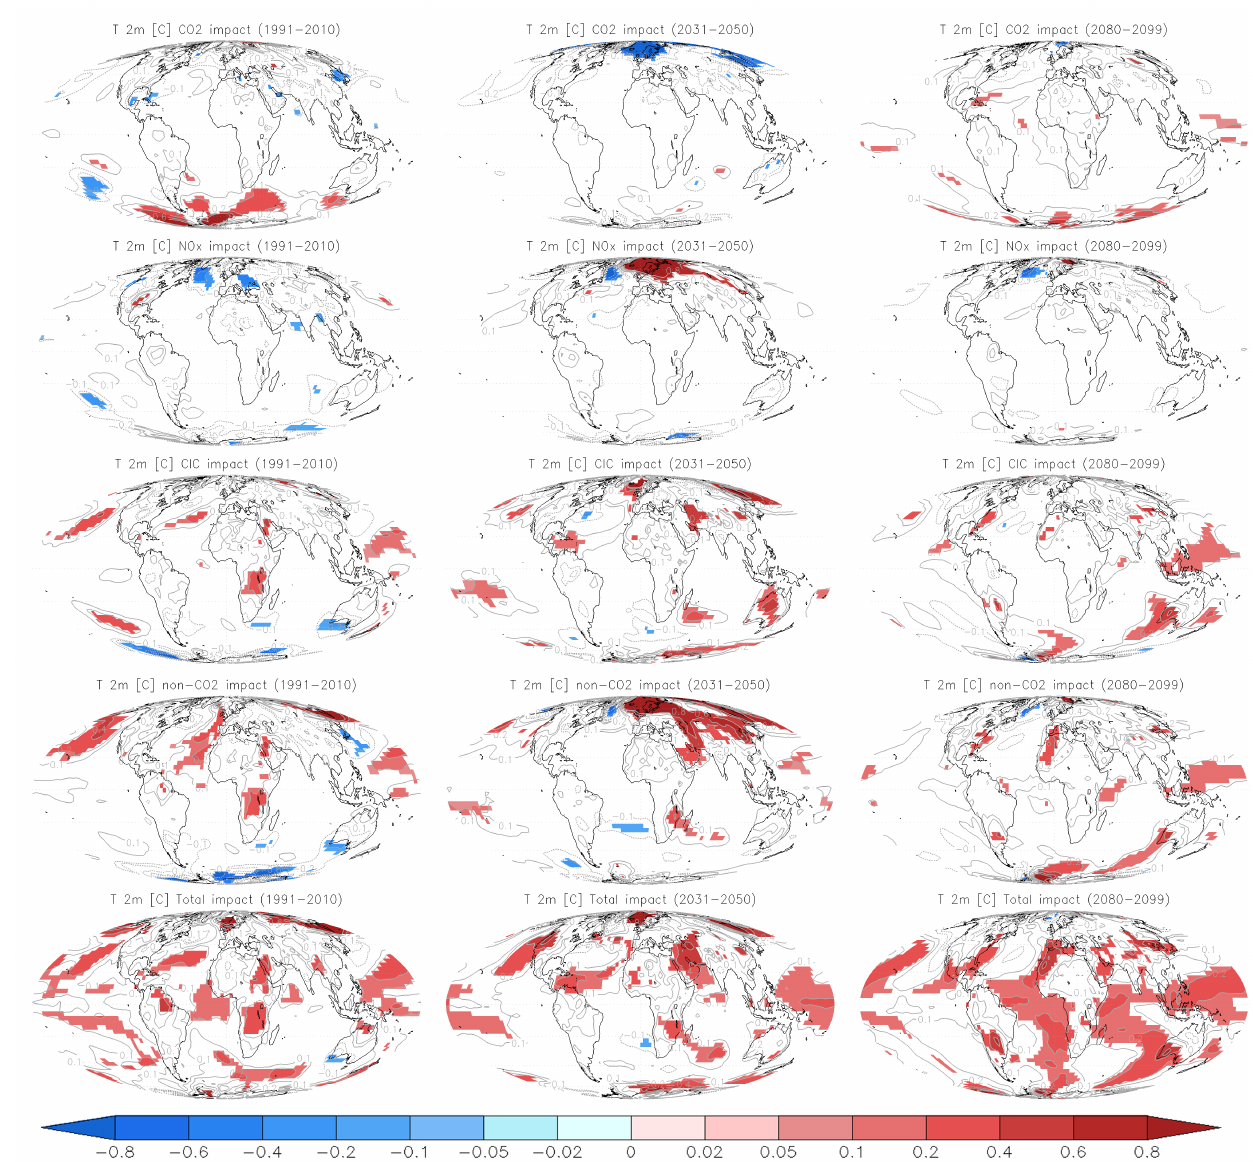
Fig. 10. Impact of aviation on near-surface temperature averaged over 1991–2010 (left column), 2031–2050 (middle column) and 2088–2099 (right column). Rows represent the CO 2 (first row), NO x (second row), CIC (third row), non-CO 2 (fourth row) and all the aviation effects (fifth row). The shaded areas correspond to statistically significant changes at the 95% level of confidence when applying a